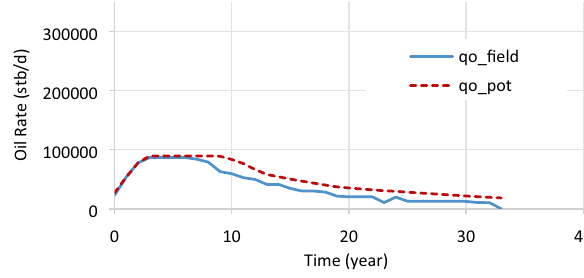
Fig. 5 Optimum oil production profile and oil production potential for strategy TLP with GL + WI